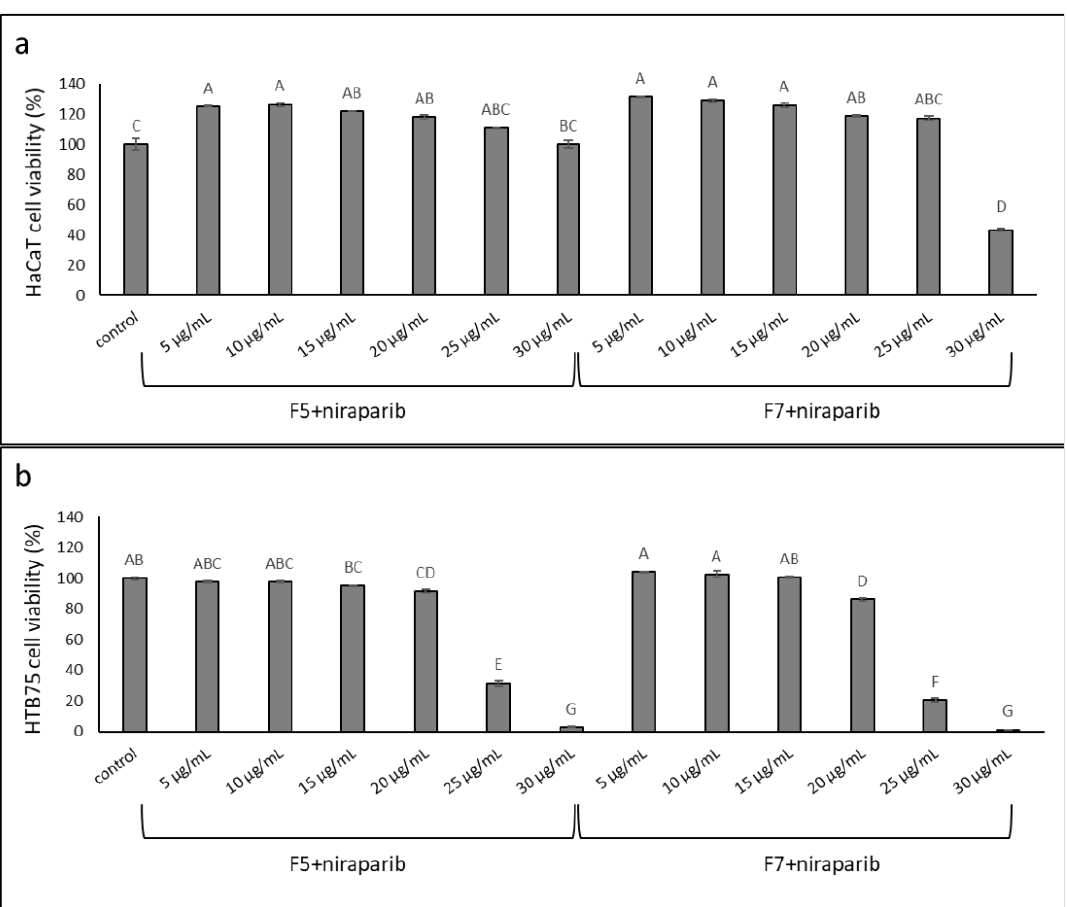
Figure 8. Cell viability of ( a ) HaCaT and ( b ) HTB75 cells following treatment at full confluence with niraparib:F5 or niraparib:F7 at ratio of 3.5:6.5, respectively, at different concentrations. Cell viability was determined by XTT assay at 48 h as a function of live cell number. Control was vehicle control (1% v/v methanol + 1% v/v DMSO). Error bars indicate ± SE ( n = 3). Levels with different Upper case letters were significantly different from all combinations of pairs by Tukey–Kramer honest significant difference (HSD; p ≤ 0.05).